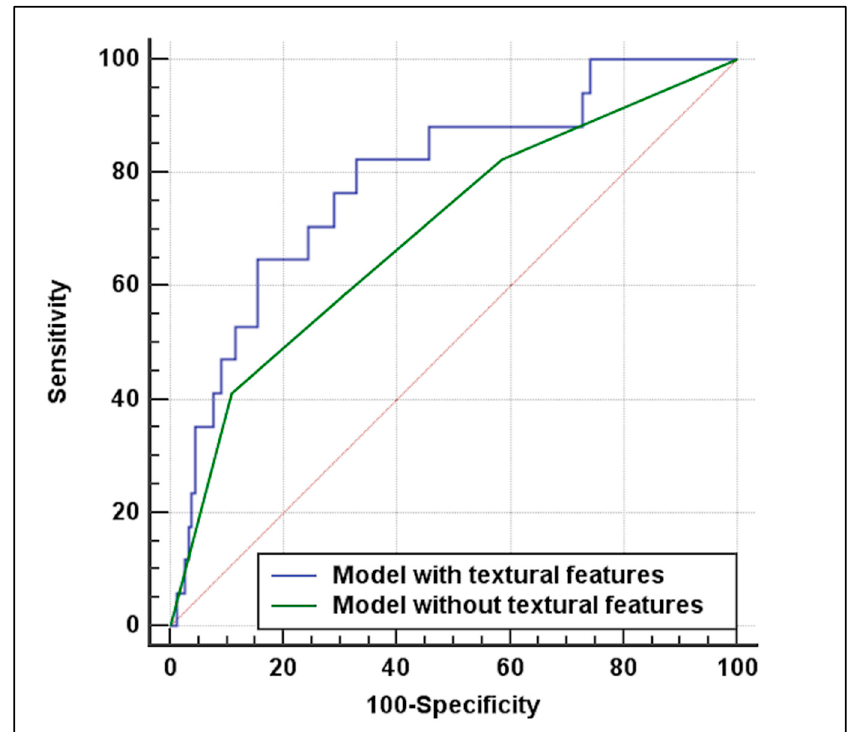
Figure 3. Diagnostic performance for prediction of unfavorable outcome (any ipsilateral neurologic acute event and periprocedural myocardial infarction or death) after carotid artery stenting. The model including textural features derived by density histogram of the plaque at CTA (blue line) outperformed the model without textural features (green line) with an area under the receiver operating characteristics curve of 0.789 vs 0.695 ( p = 0.004).